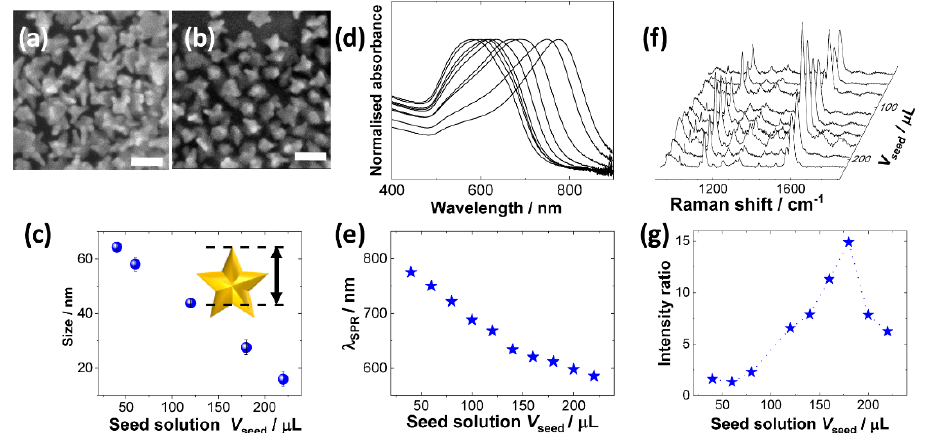
Figure 2. Characterisation of PVP-protected Au nanostars. SEM images of PVP-protected Au nanostars synthesised by different amounts of the seed solution ( V seed ). ( a ) V seed = 40 and ( b ) 140 µ L, respectively (scale bar: 50 nm). ( c ) The particle size, acquired based on the measurement of the longest length from the tip apex to the opposite core surface, was plotted as a function of V seed , where the error bar shows the standard deviation of the size distribution. ( d ) A series of UV-Vis spectra of Au nanostars synthesised with different V seed , and ( e ) SPR peak positions ( λ SPR ) as a function of V seed . ( f ) A series of Raman spectra for a dendrimer sample with shell-isolated Au nanostars with different V seed and ( g ) the corresponding signal intensity at 1580 cm − 1 as a function of V seed , normalised with that from the blank spectrum acquired in the absence of the Au nanostar.